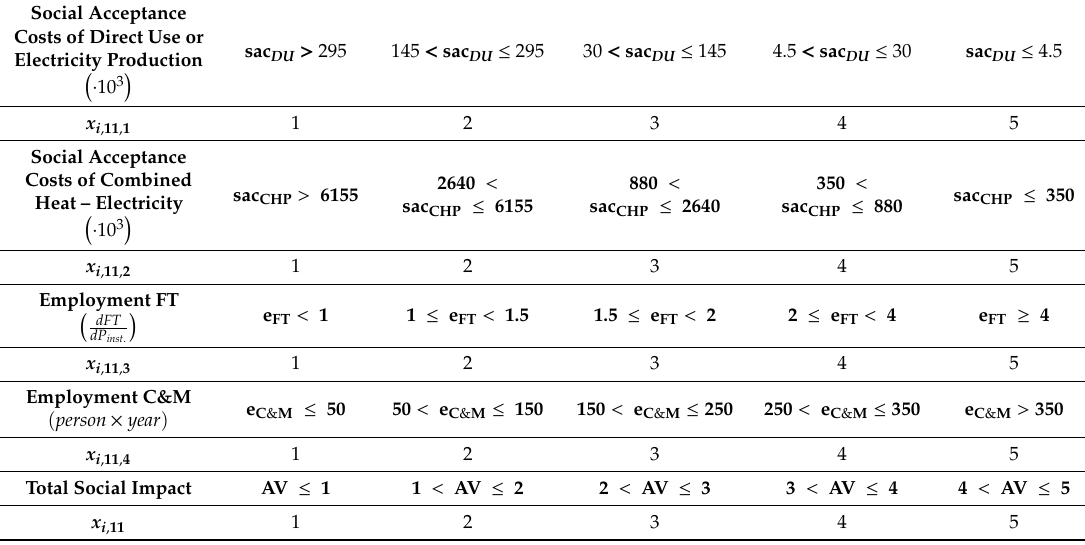
Table 11. Performance values x i ,11 for 11th